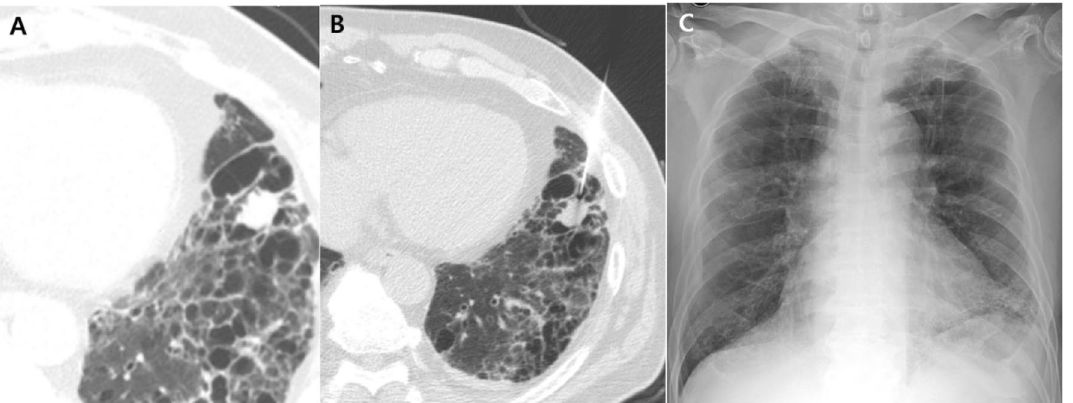
Figure 3. A 67-year-old male patient with underlying idiopathic pulmonary fibrosis. The patient showed a 1.6-cm irregular nodule in his left lower lobe ( A ). CT-guided percutaneous core needle biopsy (PCNB) was performed with the patient in the supine position. The needle traversed the honeycomb cysts ( B ). There was no complication after PCNB ( C ). Squamous cell carcinoma was confirmed through